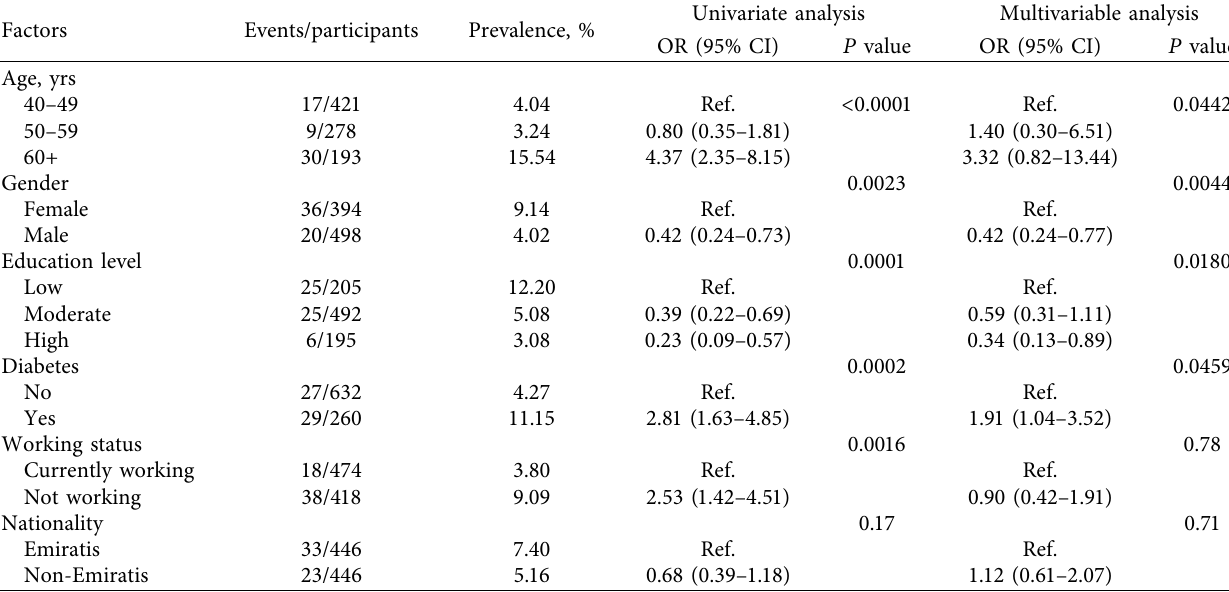
Table 4: Multivariable logistic regression analysis for risk factors associated with presenting vision impairment (visual acuity < 6/12) among the whole